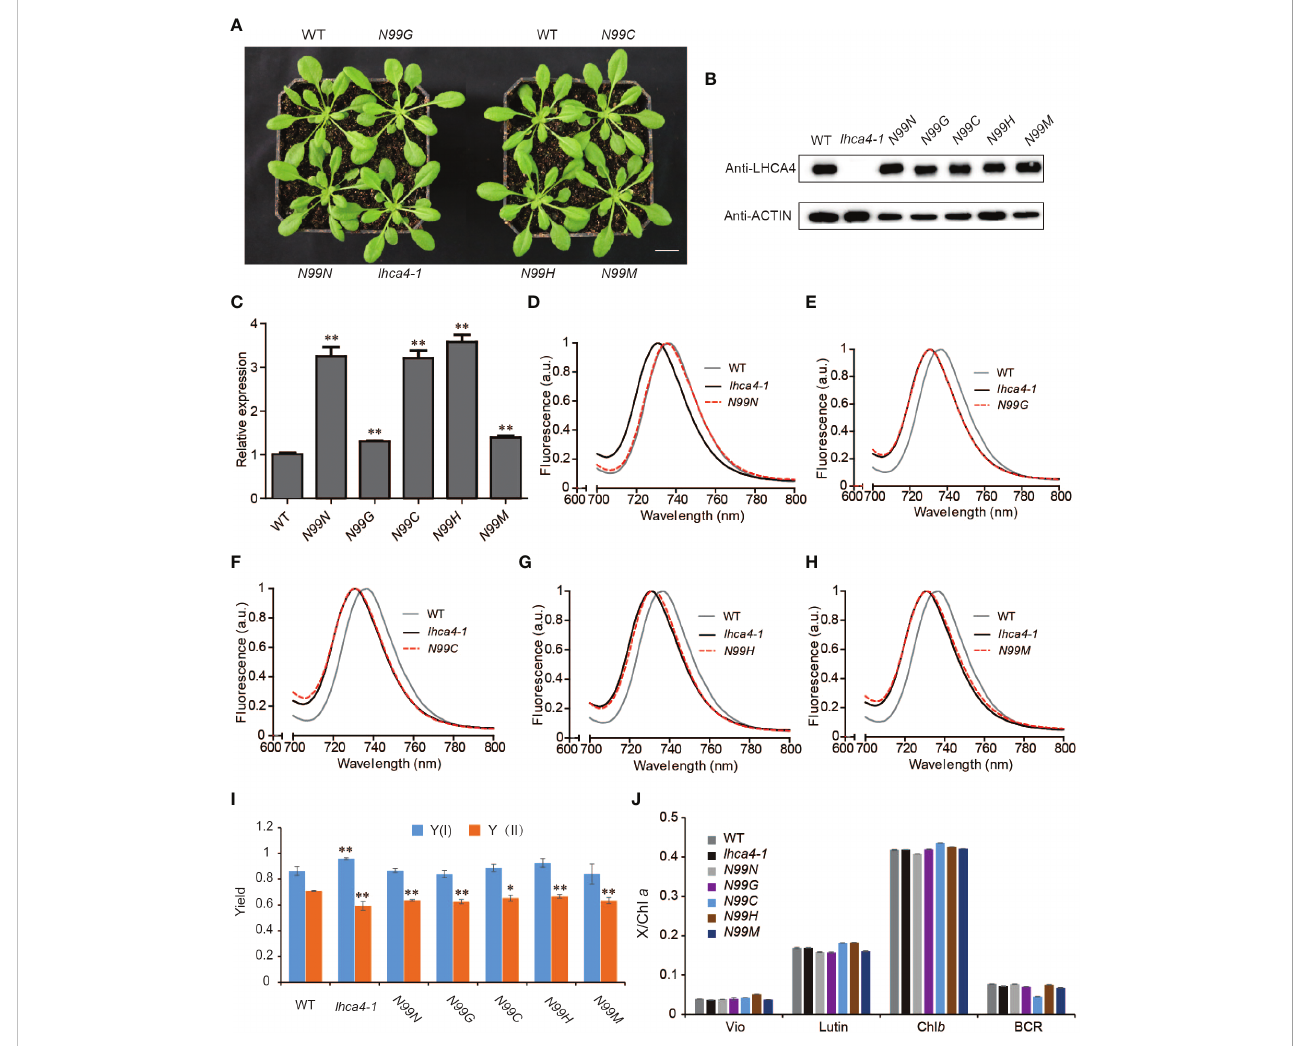
FIGURE 2 Phenotypic and physiological characterization of plants with single amino acid substitutions at N99 in LHCA4. (A) Representative photograph of the WT, lhca4-1 , the control line 35S:LHCA4 ( N99N ), and four lines harboring LHCA4 point mutations in the lhca4-1 mutant background: 35S:LHCA4 ( N99G ), 35S:LHCA4 ( N99C ), 35S:LHCA4 ( N99H ), and 35S:LHCA4 ( N99M ) (scale bars = 2 cm). (B-C) LHCA4 protein abundance analyzed by immunoblots. Anti-ACTIN antibodies were used for the immunoblots assays. (B) and relative LHCA4 expression levels detected by RT-qPCR (using the two-tailed Student ’ s t-test; **signi fi cant at P < 0.01) (C) in 5-week-old plants from the WT, lhca4-1 , the control line, and the LHCA4 point mutants. (D-H) 77K fl uorescence emission spectra for the WT, lhca4-1 , and 35S:LHCA4 ( N99N ) (D) ; 35S:LHCA4 ( N99G ) (E) ; 35S:LHCA4 ( N99C ) (F) ; 35S: LHCA4 ( N99H ) (G) ; and 35S:LHCA4 ( N99M ) (H) . The excitation wavelength was 440 nm. (I-J) Chl fl uorescence parameters of Y(I) and Y(II) (using the two-tailed Student ’ s t-test; *signi fi cant at P < 0.05, **signi fi cant at P < 0.01). (I) and pigment composition (J) in the WT, lhca4-1 , the control line, and the four LHCA4 point mutant